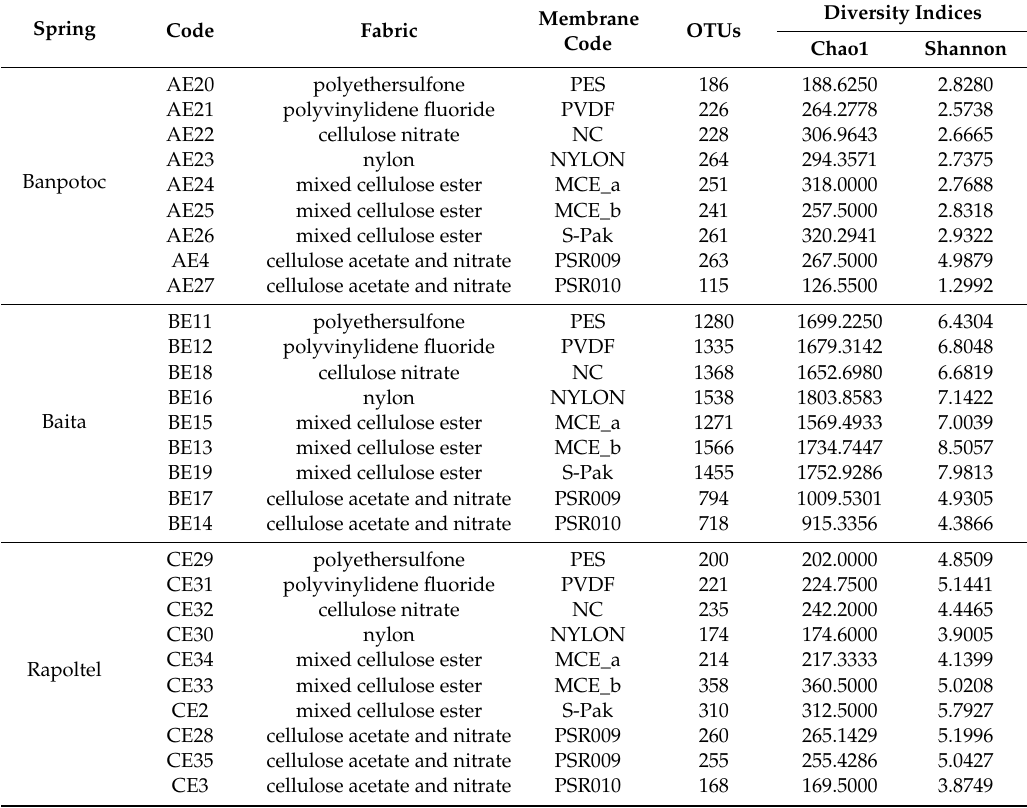
Table 3. Collected samples in the three karstic springs with their corresponding diversity indices.